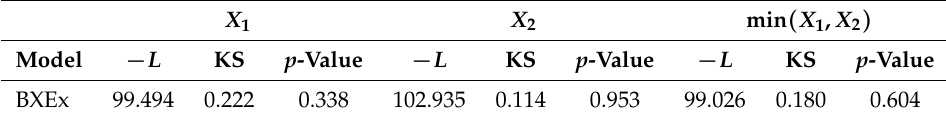
Table 12. The L, KS and p -values for the marginals using data set II.